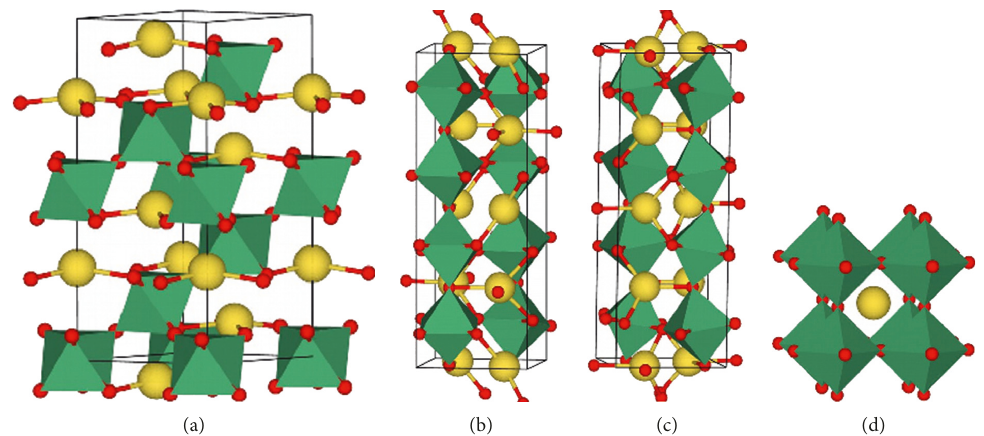
Pm 3 m , SG 221) (d).